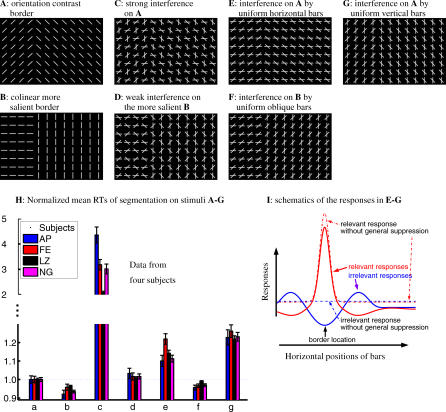
Demonstration and Testing the Predictions on Spatial Grouping(A–G) Portions of different stimulus patterns used in the segmentation experiments. Each row starts with an original stimulus (left) without task-irrelevant bars, followed by stimuli when various task-irrelevant bars are superposed on the original.(H) RT data when different stimulus conditions are randomly interleaved in experimental sessions. The un-normalized mean RT for four subjects (AP, FE, LZ, NG) in condition (A) are: 493, 465, 363, 351 ms. For each subject, it is statistically significant that RTC > RTA (p < 0.0005), RTD > RTB (p < 0.02), RTA > RTB (p < 0.05), RTA < RTE, RTG (p < 0.0005), RTD > RTF, RTC > RTE, RTG (p < 0.02). In three out of four subjects, RTE < RTG (p < 0.01), and in two out of four subjects, RTB < RTF (p < 0.0005). Meanwhile, by matched sample t-tests across subjects, the mean RT values between any two conditions are significantly different (p smaller than values ranging from 0.0001 to 0.04).(I) Schematics of responses from relevant (red) and irrelevant (blue) neurons, with (solid curves) and without (dot-dashed curves) considering general suppressions, for situations in (E–G). Interference from the irrelevant features arises from the spatial peaks in their responses away from the texture border.